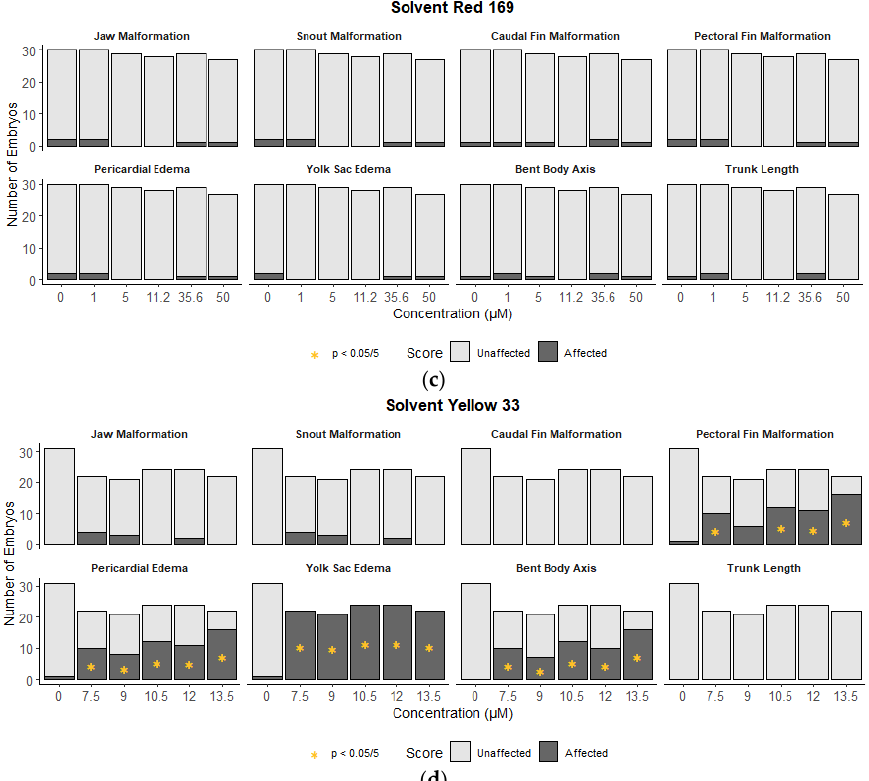
Figure 2. Summary of affected morphological endpoints in the Disperse Blue 14 ( a ), Disperse Red 9 ( b ), Solvent Red 169 ( c ), and Solvent Yellow 33 ( d ) treatment groups. * Indicates statistical significance ( p < 0.05/5). The endpoints where no effects were seen are not included.